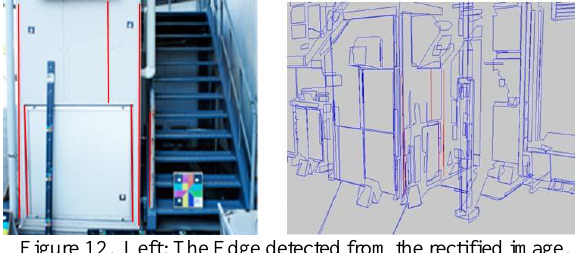
Figure 14. Assessment of